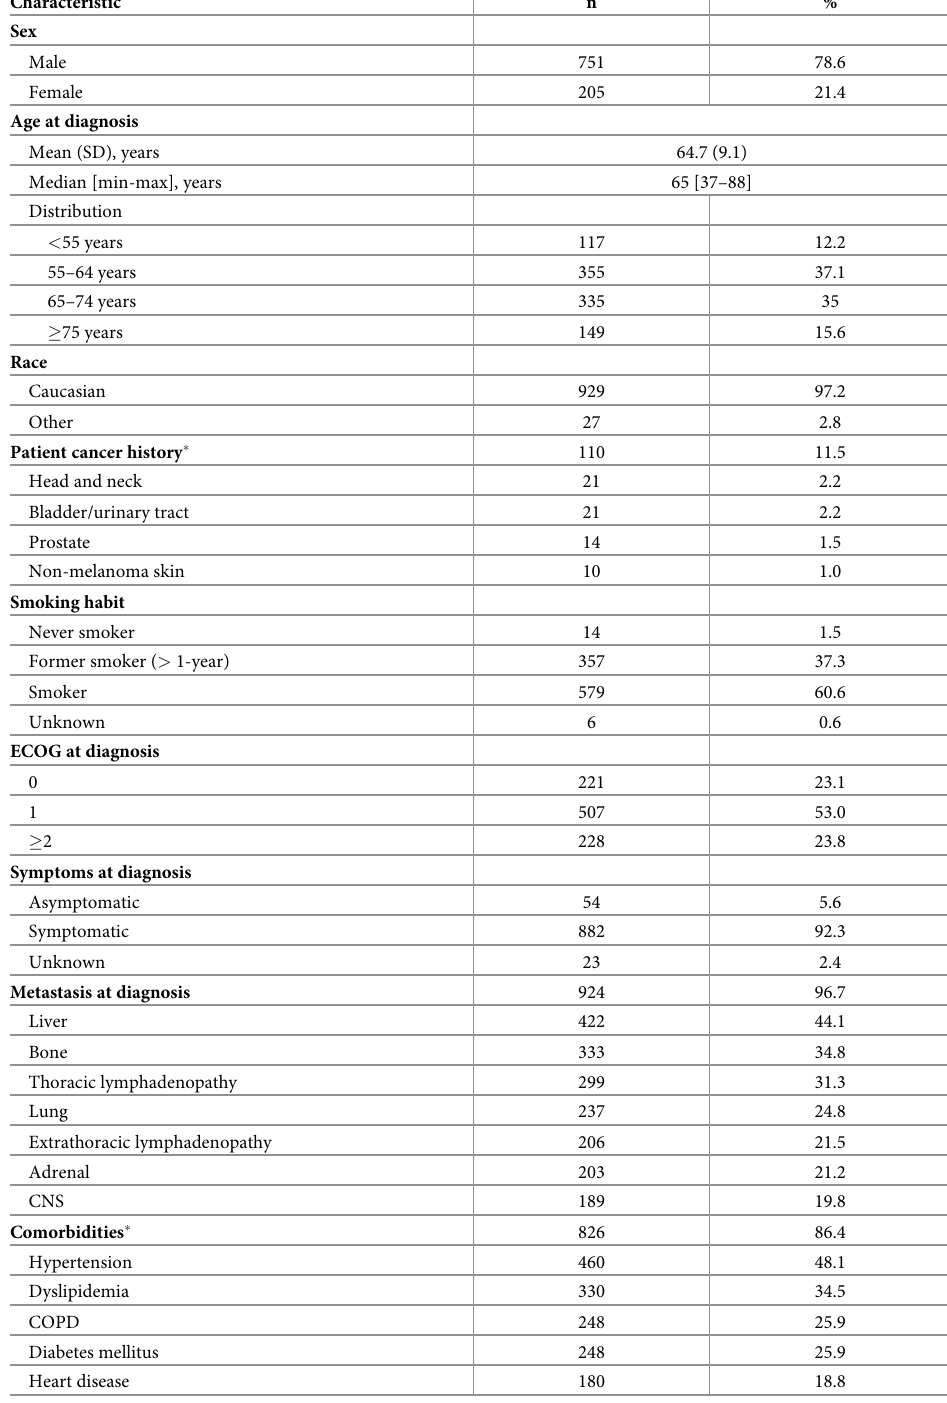
Table 1. Patient characteristics at baseline (n =